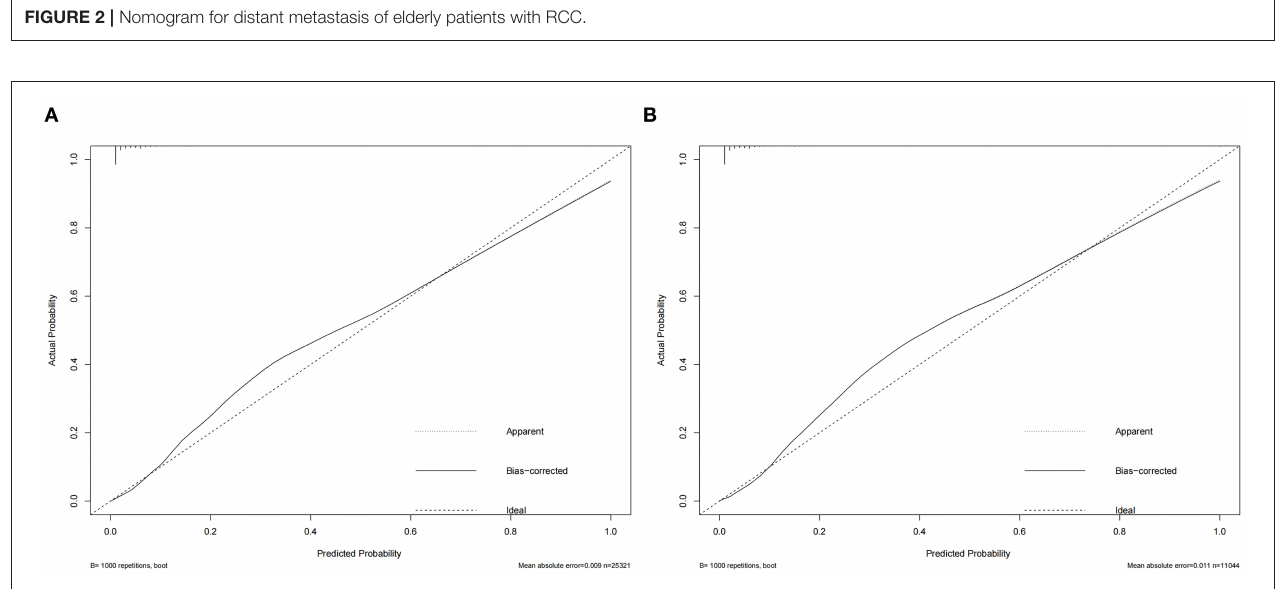
FIGURE 3 | The nomogram’s calibration curve in the training cohort (A) and the validation cohort (B) .